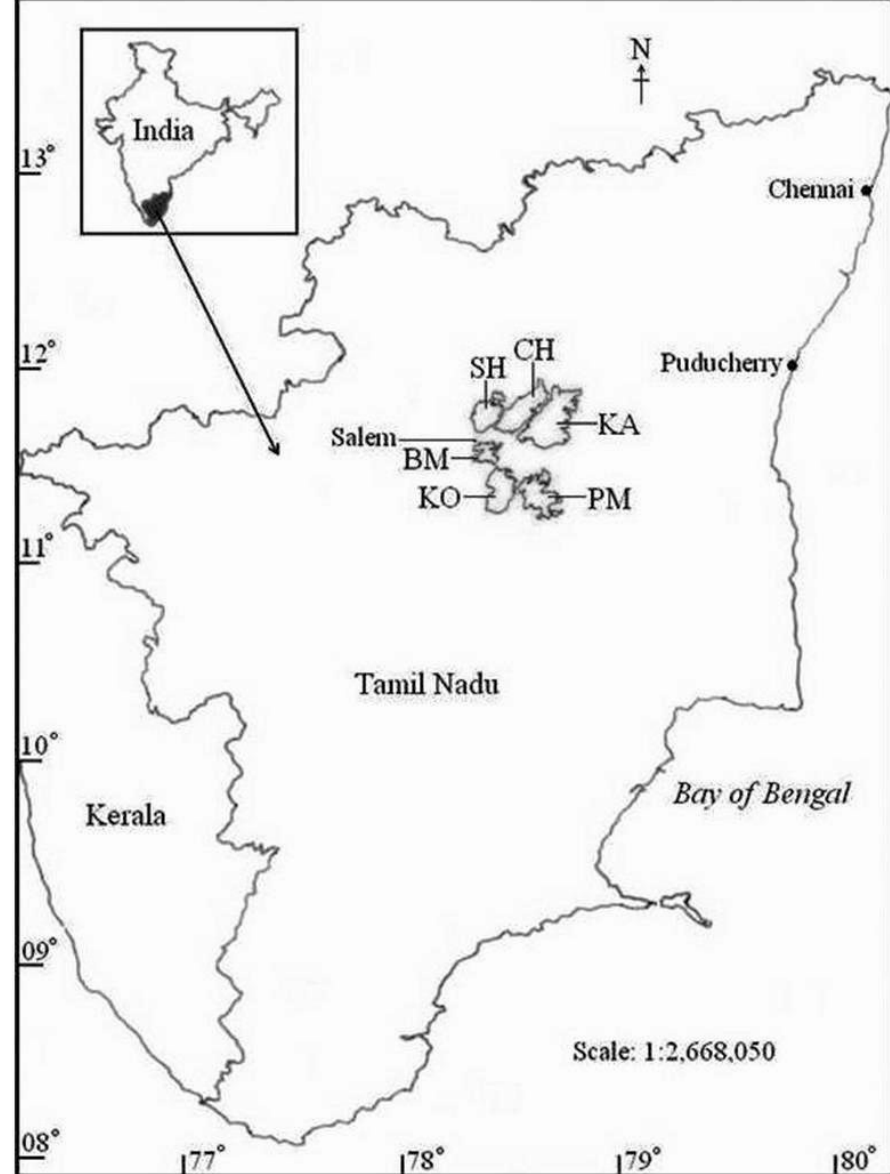
Figure 1. Map showing the study area- the six major hill complexes of southern Eastern Ghats: Bodamalai (BM), Chitteri (CH), Kalrayan (KA), Kolli hills (KO), Pachaimalai (PM) and Shervarayan hills